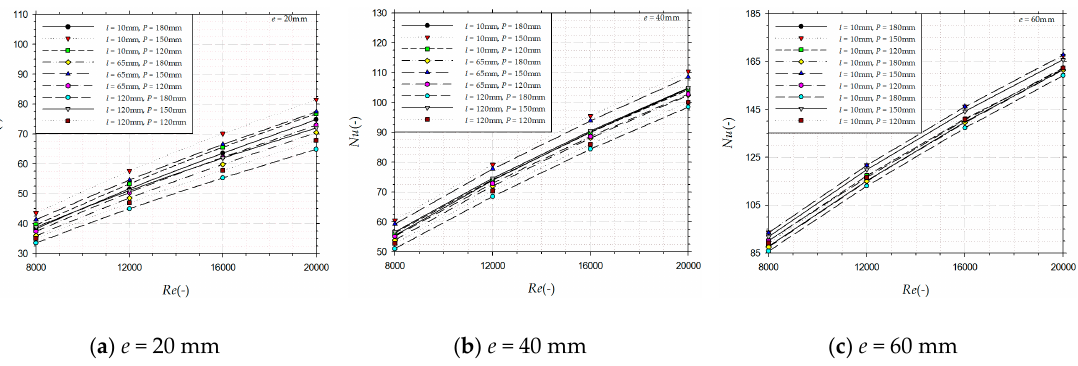
Figure 5. Nusselt number for different value of pitch ( P ), length ( l ), and for a fixed value of height ( e ) with Reynolds number.